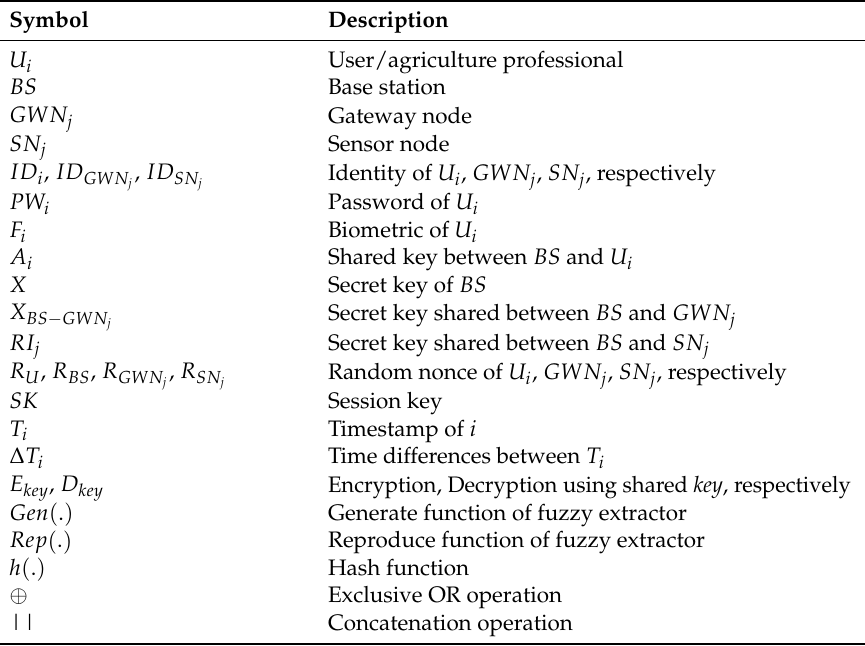
Table 1. Notations of the proposed